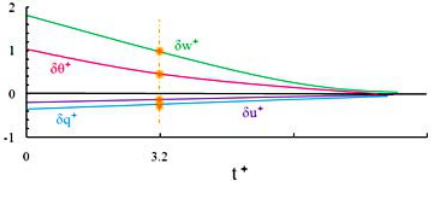
Fig. 10 Disturbance δ u + , δ w + , δ q + , and δθ + in the stable slow subsidence mode.